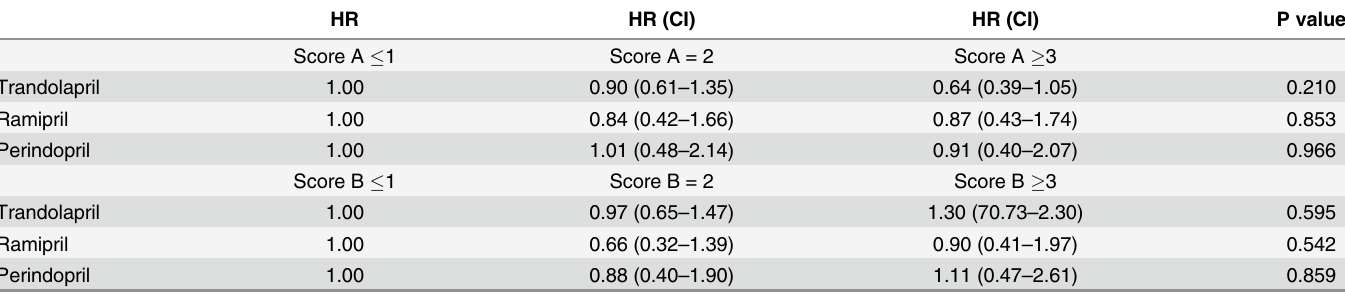
Table 6. Risk of cardiovascular (CV) death with genetic scores A and B in patients treated with trandolapril, ramipril or perindopril.